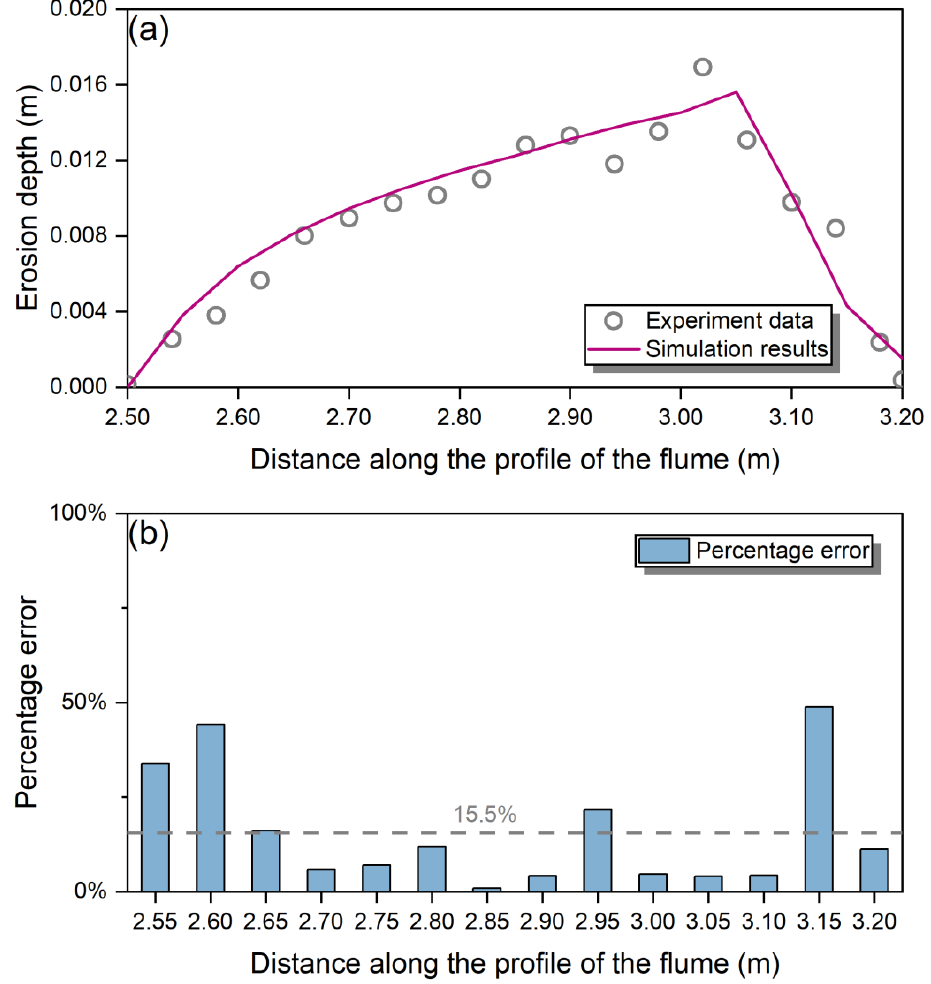
Figure 11. Erosion depth distribution at different locations at t = 1.5 s. ( a ) Comparison of experimental data and numerical simulation results. ( b ) Error percentage of erosion depth numerical simulation results.